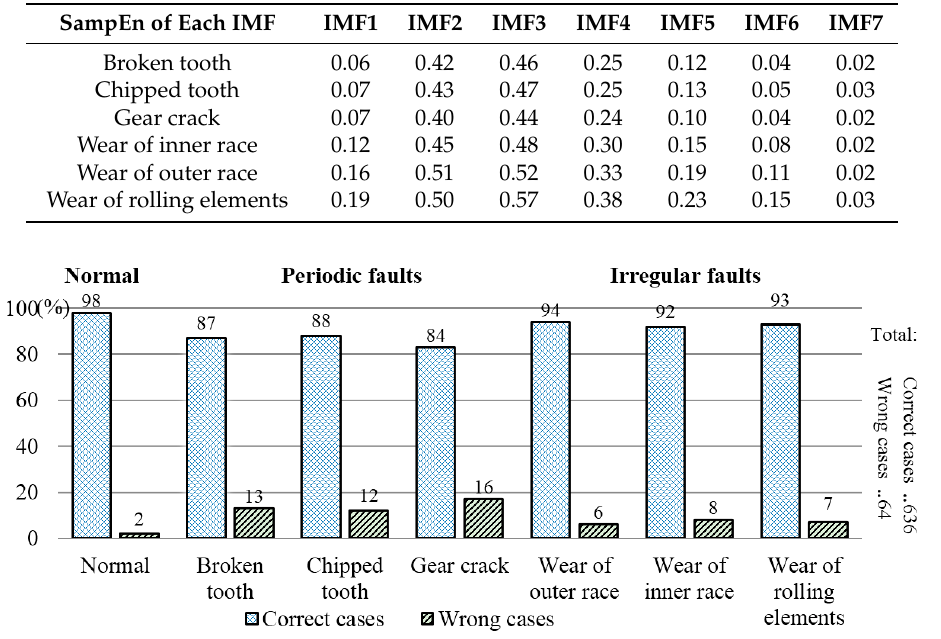
Table 6. The values of SampEn of each IMF of each fault type.